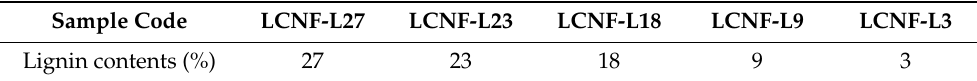
Table 1. Sample codes of lignocellulose nanofibrils (LCNFs) with di ff erent lignin content